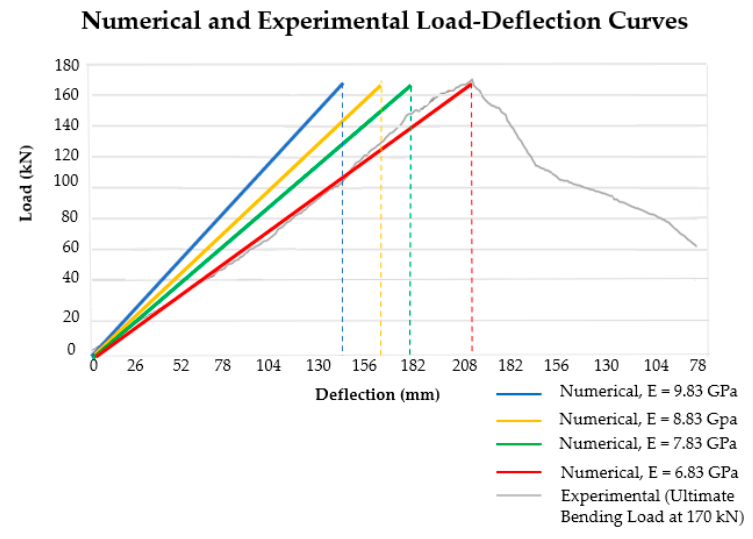
Figure 16. Comparison of the load–deflection curves between the numerical and experimental results under bending loading.